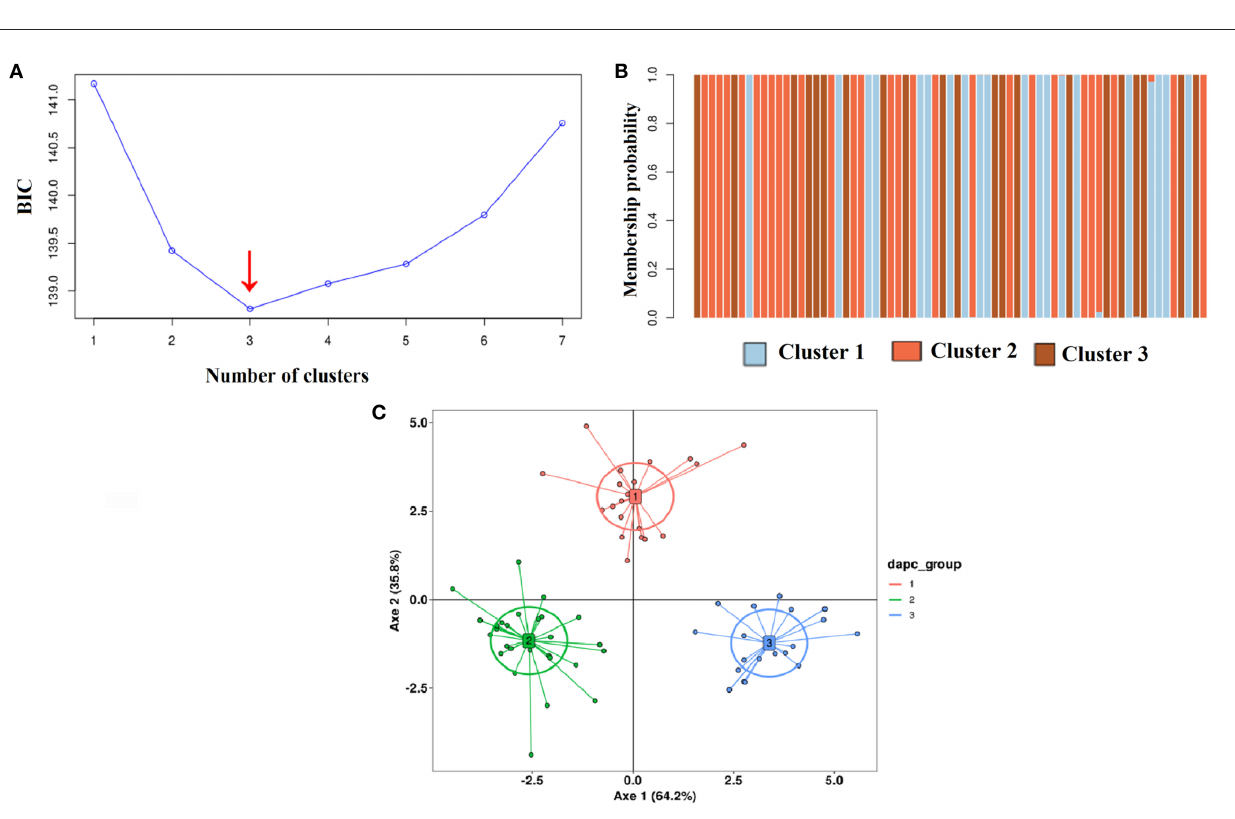
FIGURE7 (A) Bayesian information criterion (BIC) scatter plots of the DAPC indicating that the best number of groups is three (red arrow) for the total set of 69 selected symptomless cassava accessions. (B) Probabilities of belonging to the groups of each accession based on the discriminant functions of the discriminant analysis of principal components (DAPC) for all 69 selected symptomless cassava accessions. Each accession is represented by a vertical bar. The membership coefficient of the accessions varied from 80 to 100%. (C) Graphical representation of the three genetic groups obtained with DAPC for the 69 symptomless selected accessions, each indicated by different colors. The points represent different